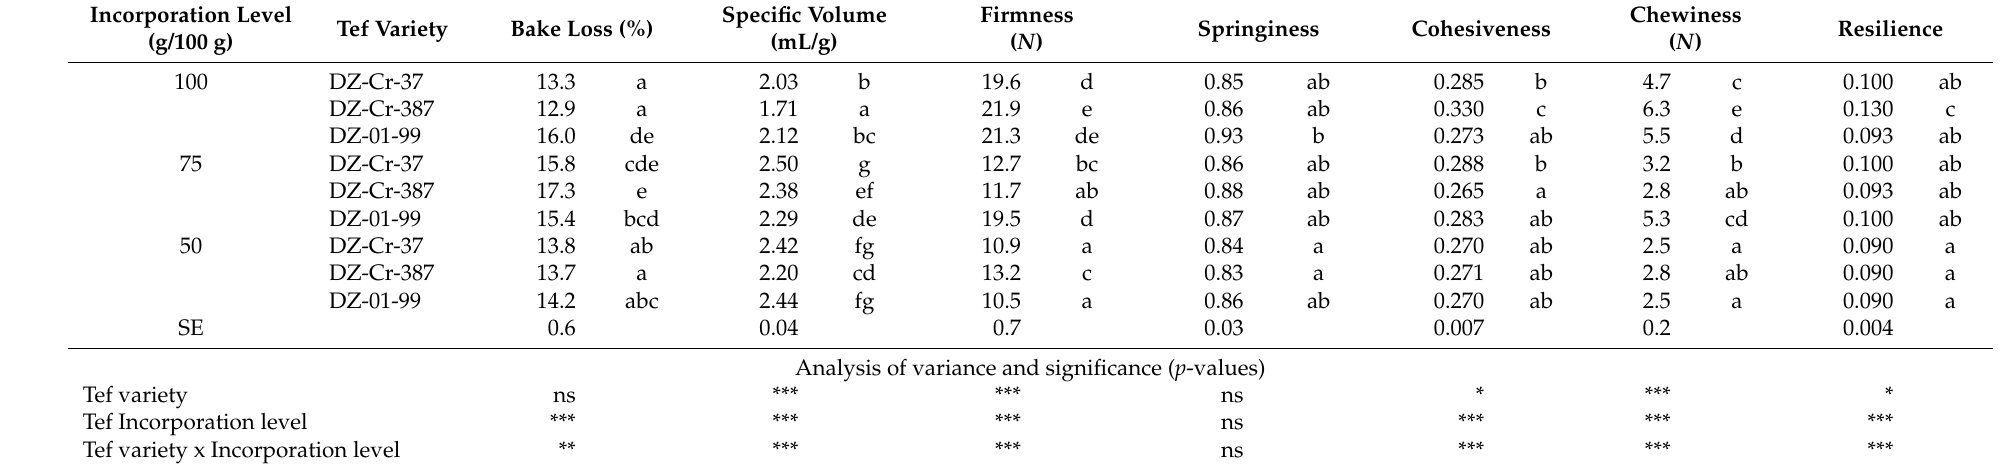
Table 1. Effect of tef incorporation level and variety type on the physical quality parameters of GF